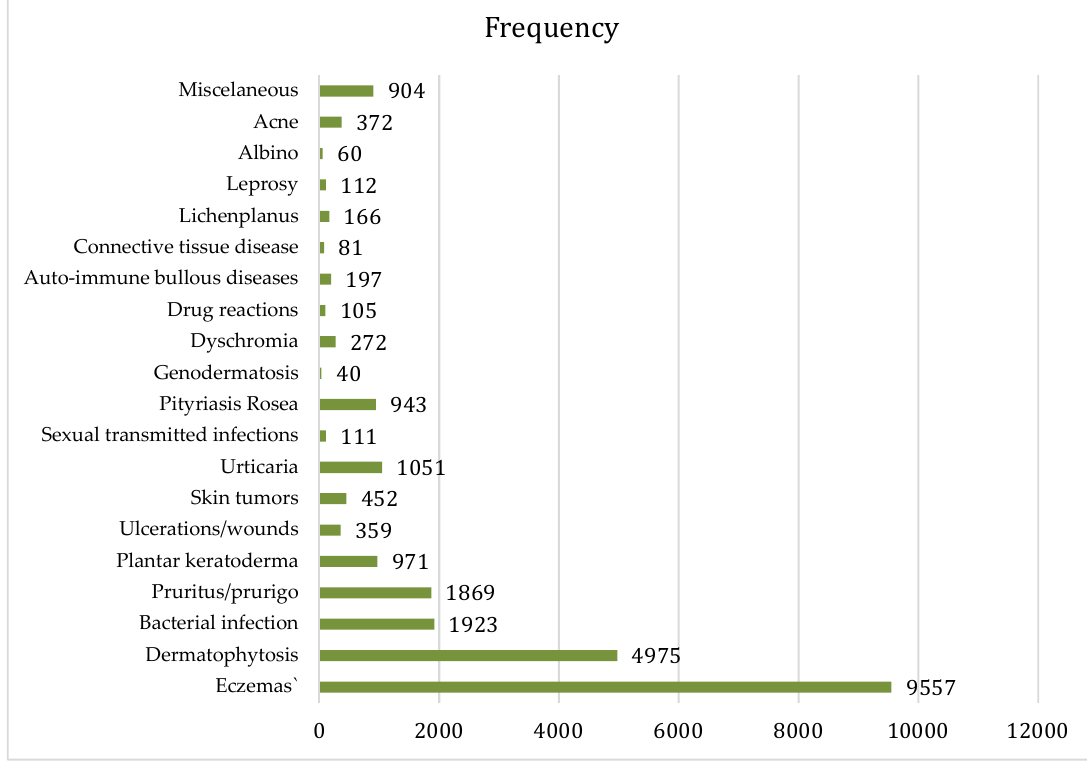
Figure 7. Pattern of skin diseases seen in the Referral centre of Dermatology at the Marchoux Institute in 2015: 24,520 cases.